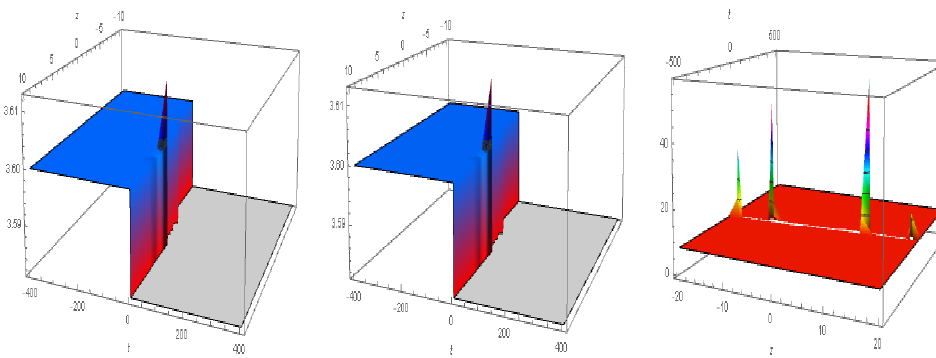
Figure 9. The KMB graphs of the solution ∆ 5 in Equation (19) are interpreted through values of a 1 = 2, a 3 = 1, a 4 = 3, ω = 5, p 1 = 2, p 2 = 3, b 1 = 1, b 2 = 2.5, b 3 = 1, b 4 = 2 and ρ = 4. Three-dimensional profiles at (i) a 2 = 5, (ii) a 2 = 20 and (iii) a 2 = − 1.